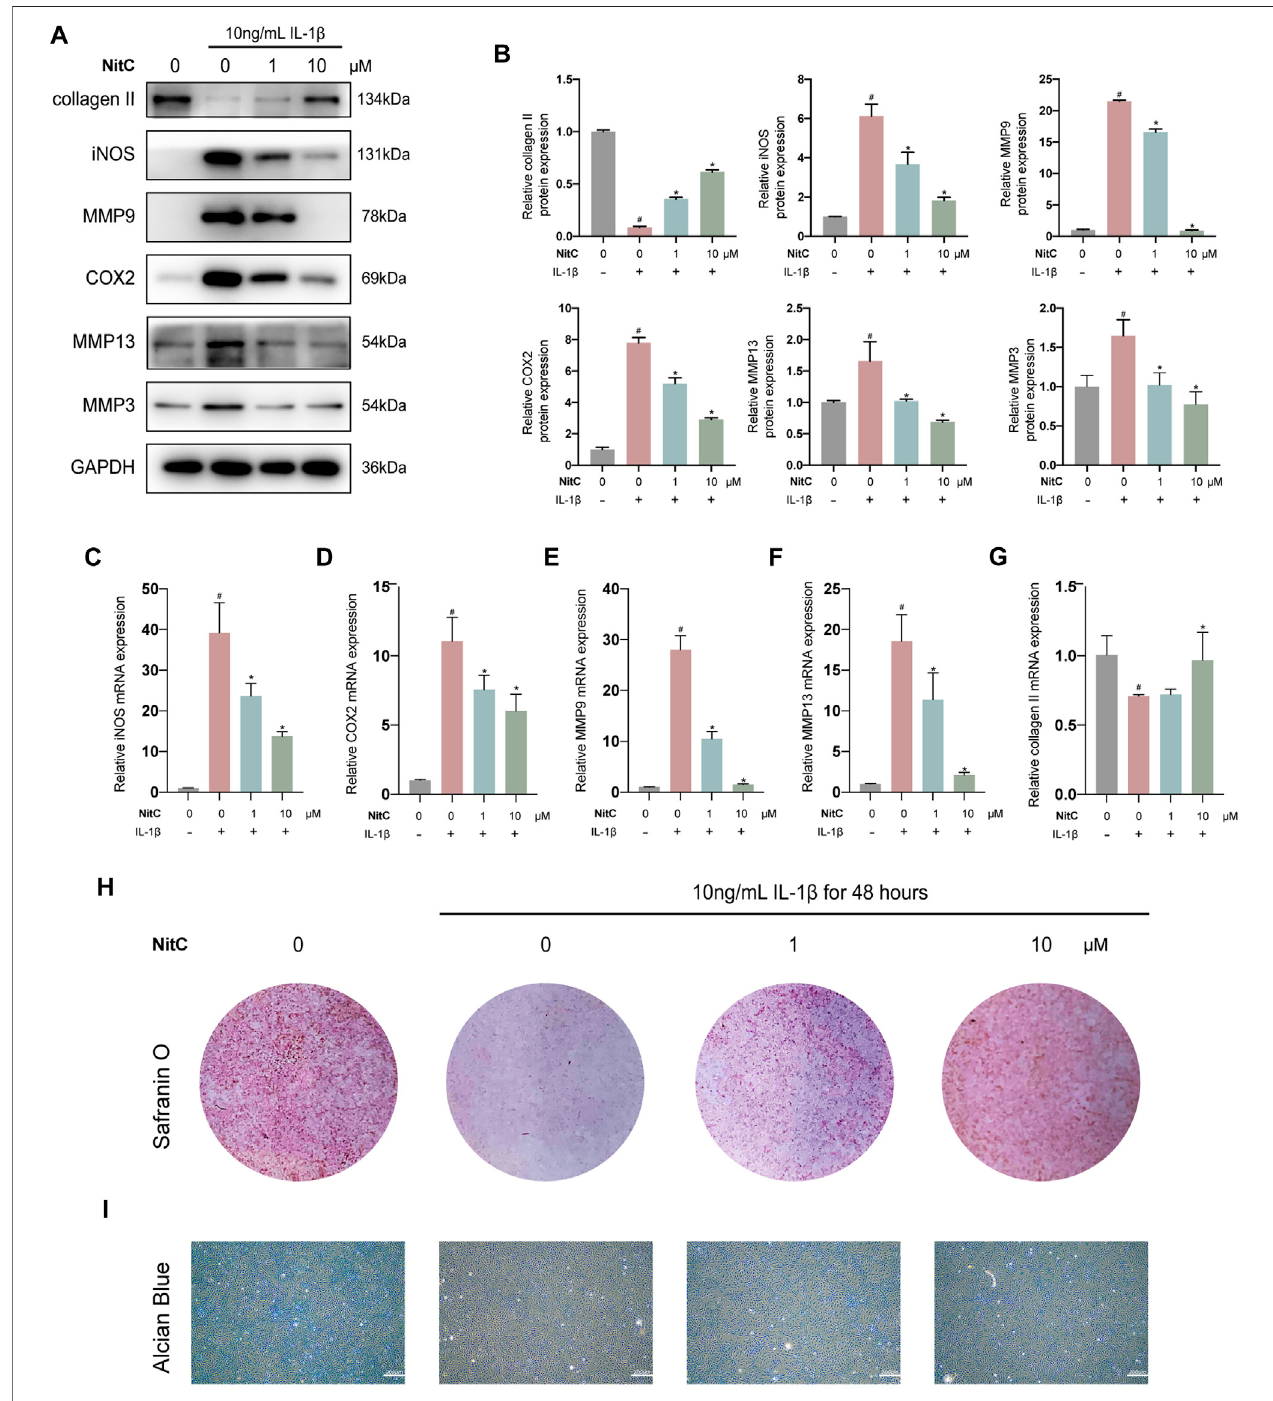
FIGURE2| NitCalleviatedECMdegradationandinhibitedRACsin fl ammation invitro . (A) TheWBanalysisofCOL2,iNOS,MMP9,COX2,MMP13,MMP3,andGA was conducted and their relative protein expression (B) was shown. (C – G) The qRT-PCR analysis was performed to detect the relative mRNA expression of iNOS, MMP9, MMP13, COX2, and COL2. (H) Representative images ofthe SafraninO staining ofpretreated chondrocytes. (I) The microscopicimagesof Alcian Blue staining of pretreated chondrocytes. #p < 0.05 versus the control group. p p < 0.05 versus the model group. Scale bars = 200 μ M.